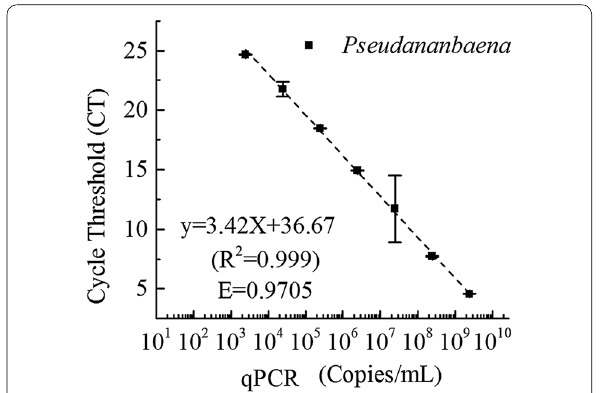
Fig. 4 Standard curve used for the qPCR assay